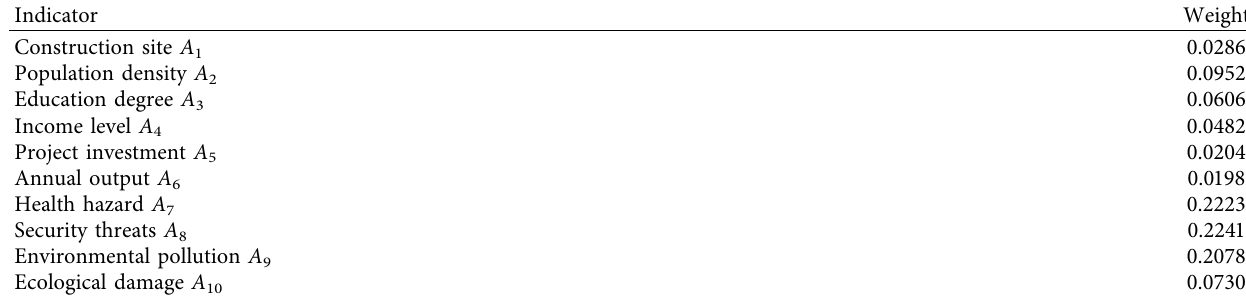
Table 3: Weights of indicators of public risk perception on PX